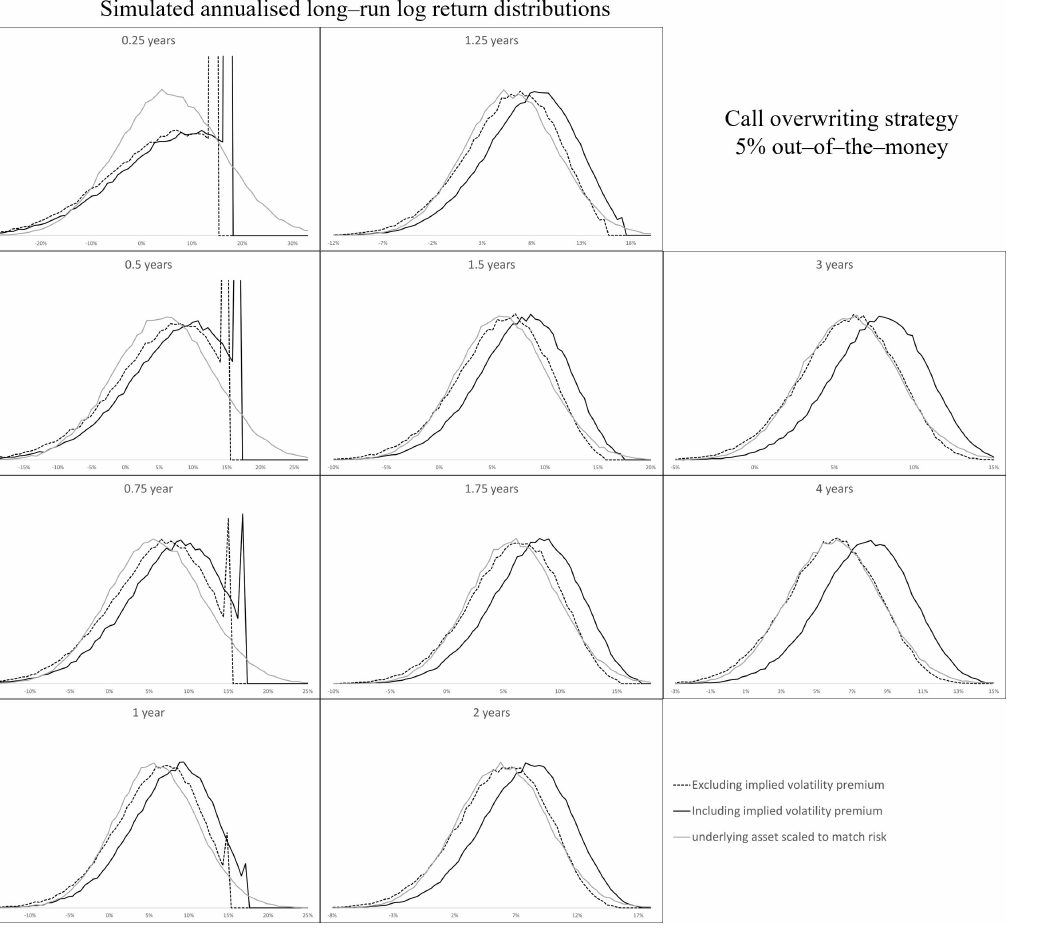
Figure 20. Simulations of the long-run returns of an underlying asset overlaid with a quarterly 5% out-of-the-money call overwriting strategy over investment horizons of 1 / 4 year, 1 / 2 year, 3 / 4 year, 1 year, 1 1 / 4 years, 1 1 / 2 years, 1 3 / 4 years, 2 years, 3 years, and 4 years. The dotted line assumes the implied volatility is equal to the underlying asset volatility. The solid line includes the implied volatility premium in the price of the options. The gray line shows the long-run returns of a portfolio consisting of the risk-free asset and the underlying asset weighted to have the same risk as the option